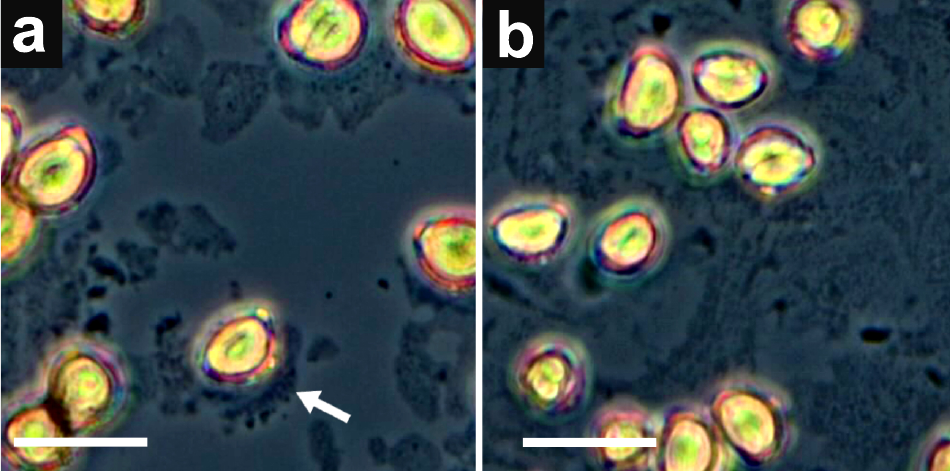
Figure 4. The phase-contrast microscopy of the pollenkitt in A. cepa : ( a ) pollen grains immediately after placing on a droplet of distilled water; pollenkitt appears as fragments released from the surface of pollen grains (white arrow). ( b ) the same pollen grains after 5 min; pollenkitt appears as a ”blanket” that keeps pollen grains on the surface of the droplet. Bars represent 50 µ m.